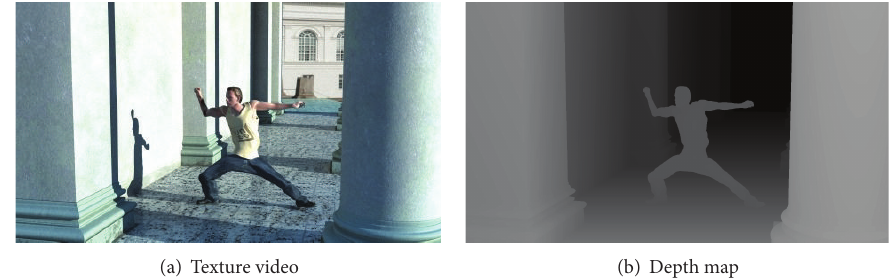
Figure 1: Texture video and corresponding depth